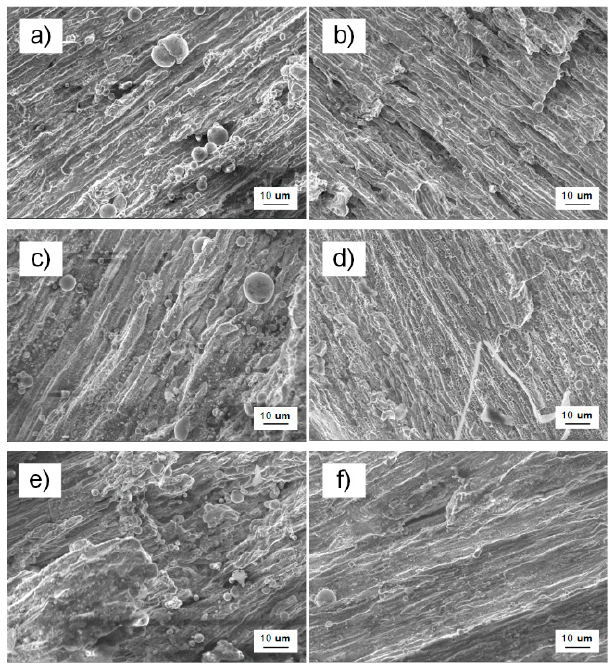
Figure 12. SEM micro-morphology fracture surface of three-point bending specimen ( a , b ) for specimen 1; ( c , d ) for specimen 2; and, ( e , f ) for specimen 3; steel on the left and copper on the right.